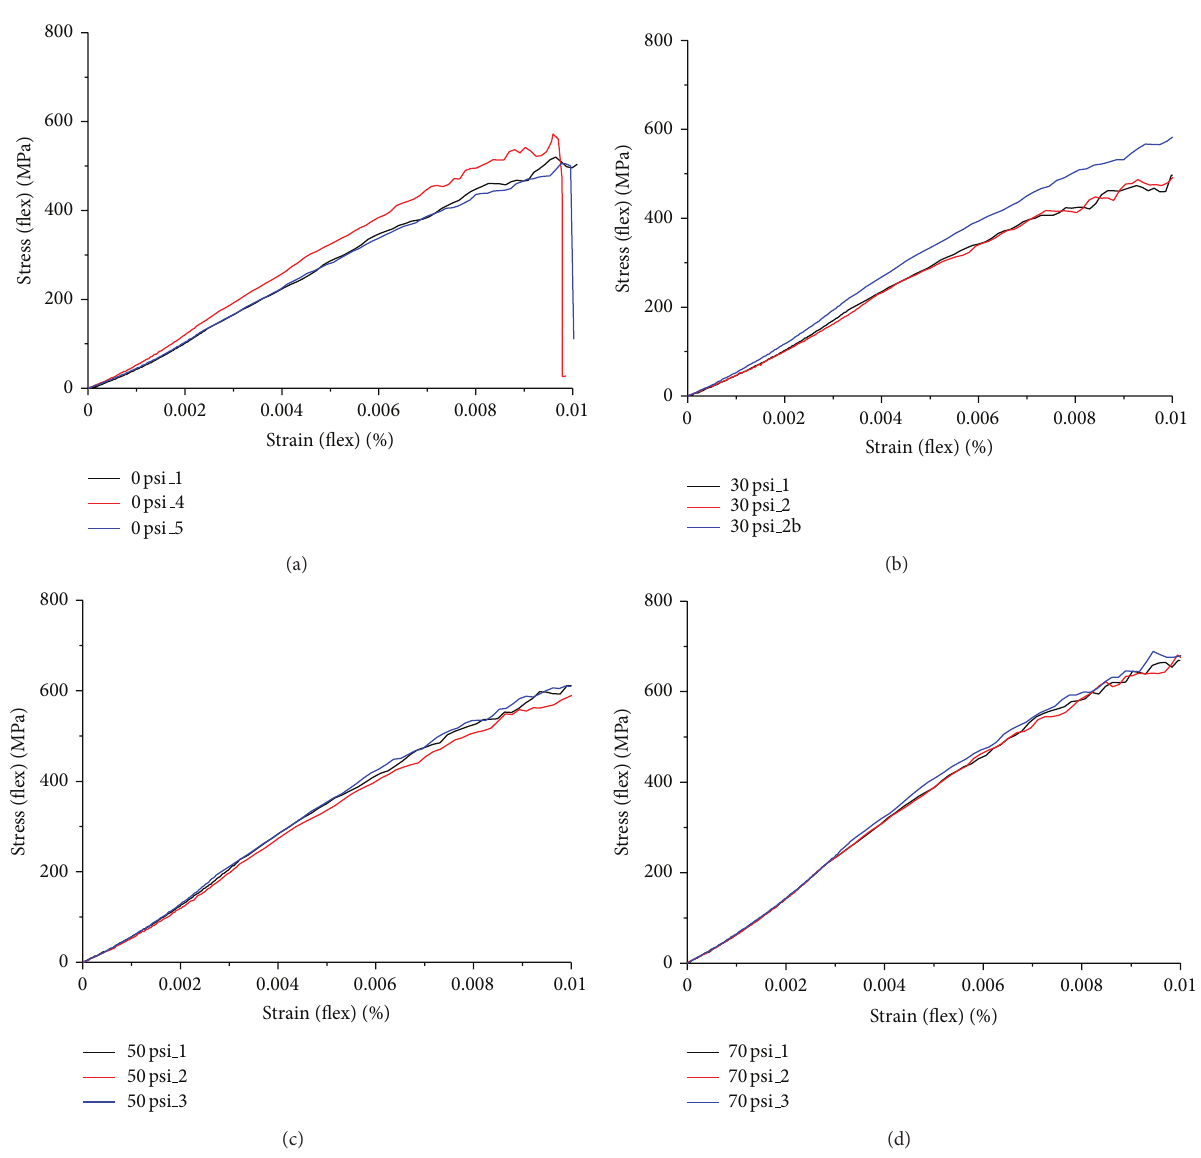
Figure 14: Flexural testing stress-strain curves for (a) 0psi, (b) 30 psi, (c) 50psi, and (d) 70